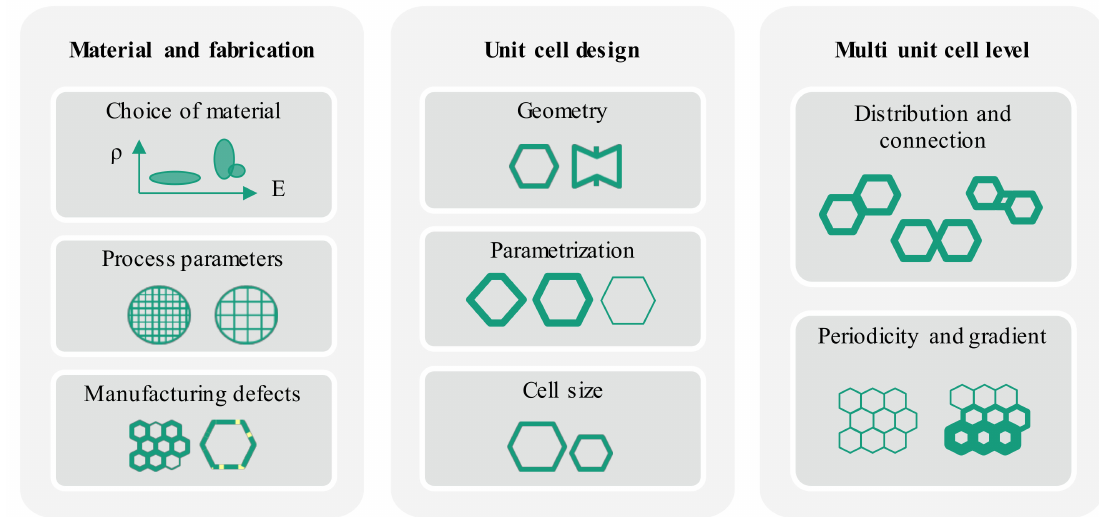
Figure 2. Design space of mechanical metamaterials: parameters originating from material and fabrication, unit cell design and multi unit cell level